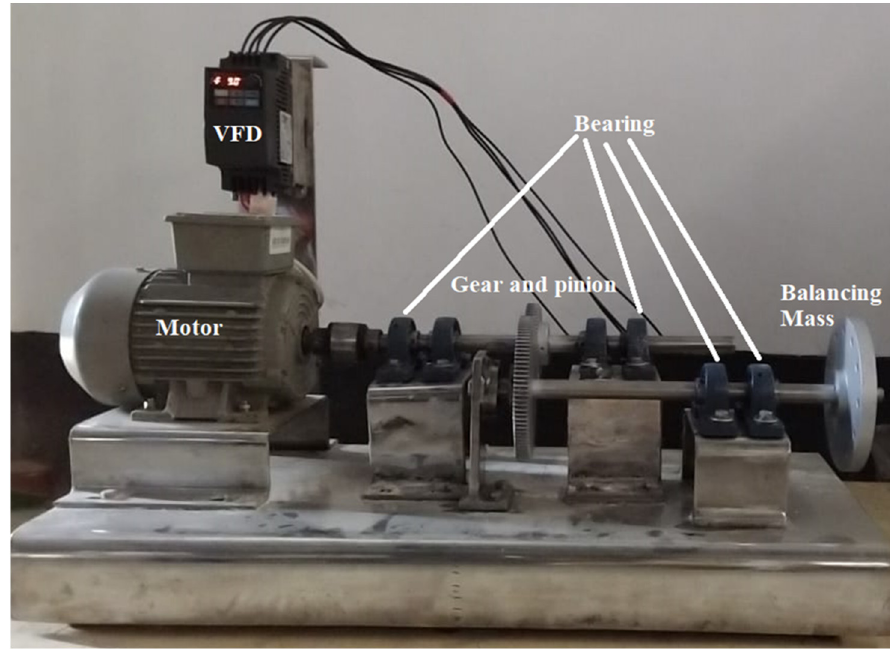
Figure 1. Photograph of the experimental